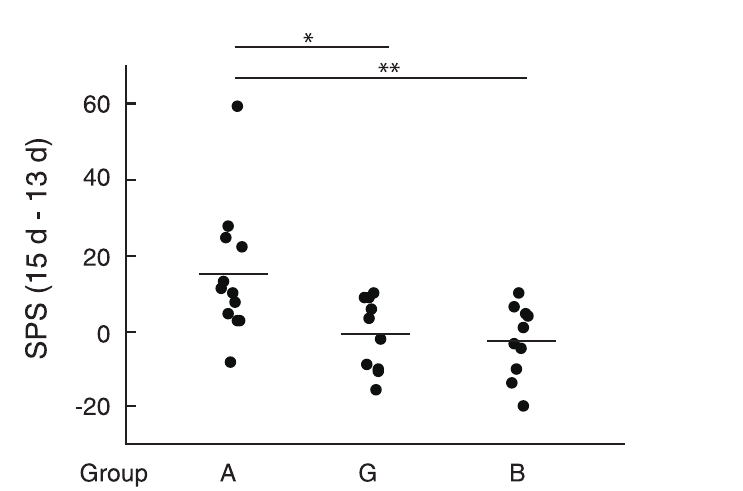
Fig 10. Effects of apyrase on the pain-related behaviors. Calculation of single paw standing of mice belonging to group A, B and G were performed according to the methods described under Materials and methods. In this experiment, PBS was injected instead of apyrase on day 13 in group A and B. Data from three experiments were combined. Total number of mice used were 12, 10 and 10 for group A, group G and group B, respectively. Each dot represents difference of single paw standing ( Δ SPS) between day 15 and day 13 of a single mouse. Averages were shown by bars. � p < 0.02, �� p < 0.01.